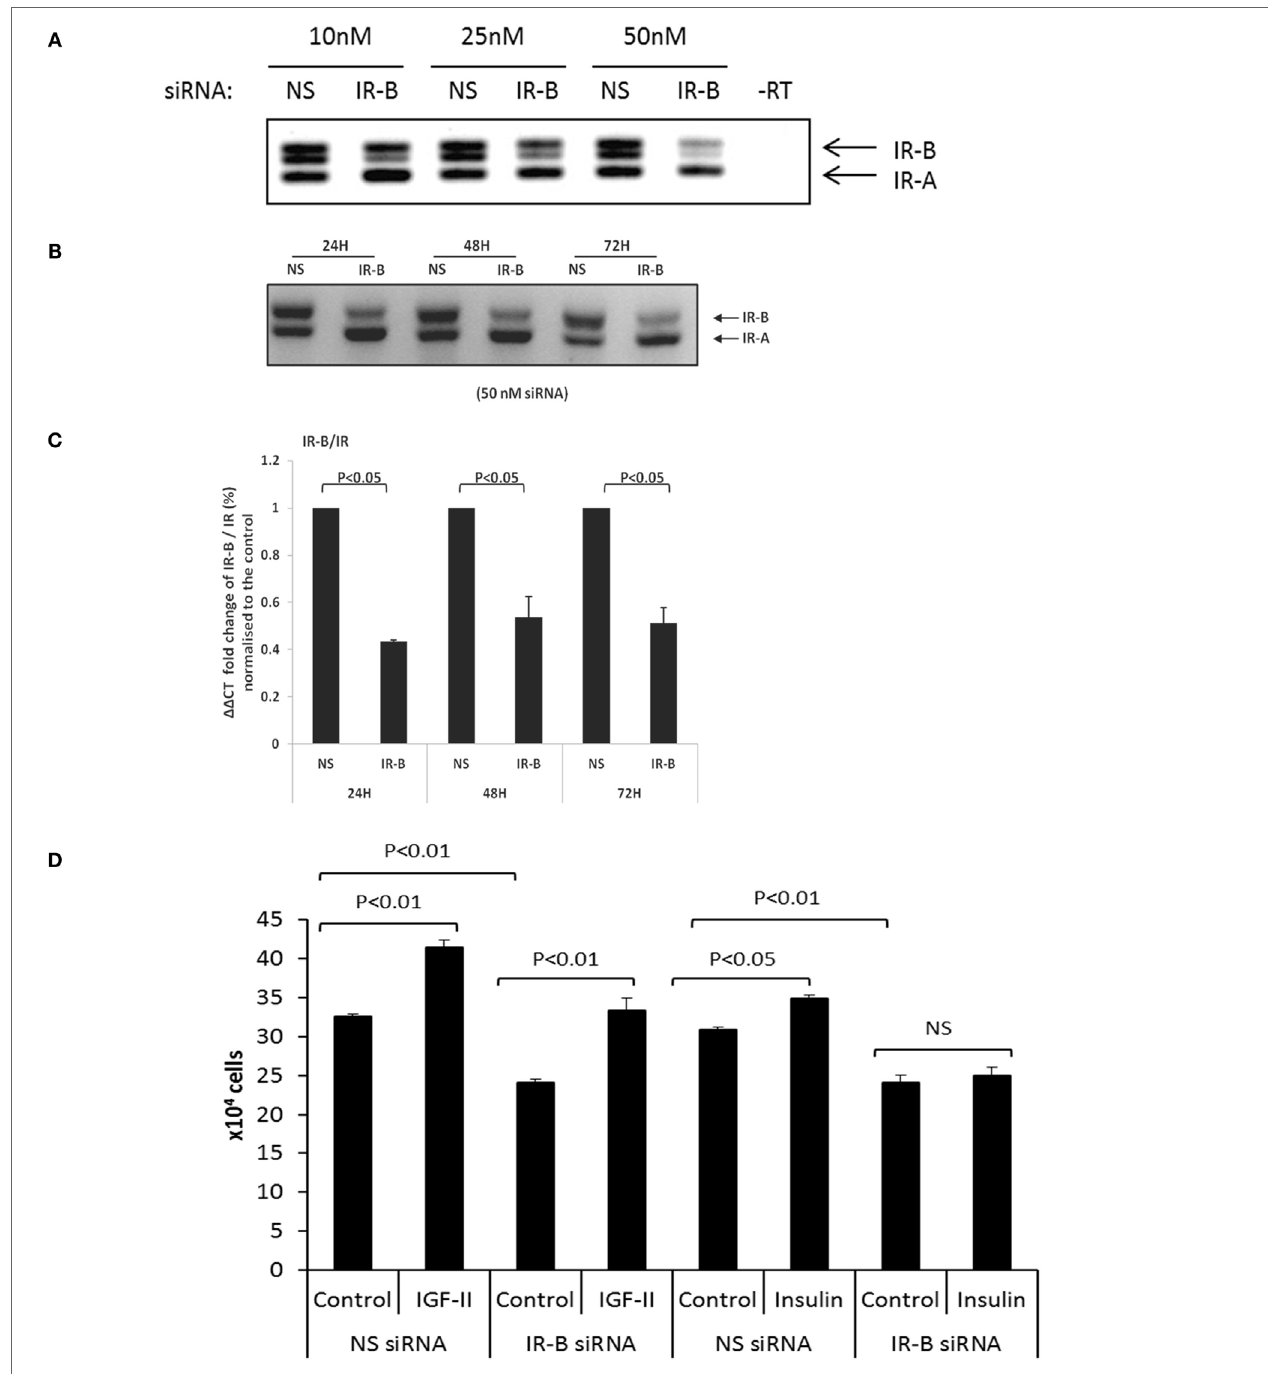
FigUre 2 | (a) RT-PCR blot in which siRNA (10, 25, and 50 nM) was used to specifically silence IR-B in DU145 cells. Cells treated with a non-silencing (NS) siRNA acting as a negative control. After 24 h, sample RNA was extracted and RT-PCR was used to assess the expression of the IR-B isoform. This is representative of blots performed at least three times. (B) Representative RT-PCR blot shows the effect of 50 nM IR-B siRNA in DU145 cells after 24, 48, and 72 h of treatment. A non-silencing siRNA acted as a negative control. This is representative of blots performed at least three times. (c) Q-PCR ΔΔ CT IR-B/IR fold expression (%) normalized to non-silencing samples. IR-B was silenced for 24, 48, and 72 h in DU145 cells. Error bars represent the SE of the mean from three experiments each repeated in duplicate ( n = 3). (D) DU145 cells were seeded in six well plates (0.1 × 10 6 cells per well) in the presence or absence of target siRNA to the IR-B or non-silencing (NS) siRNA for 24 h and then switched to serum-free media for a further 24 h followed by dosing with IGF-II or insulin for 48 h. Changes in cell proliferation were assessed by direct count of viable cells in a hemocytometer. Results shown are the mean of three independent experiments each repeated in triplicate. Data are represented as mean ± SEM.